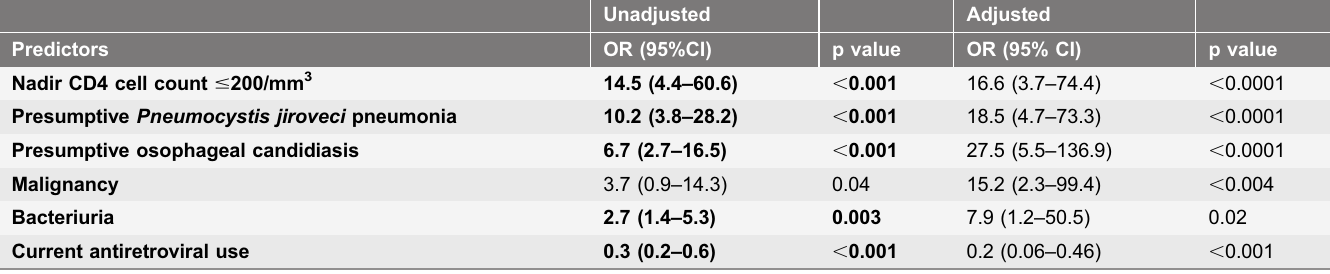
Table 3. Independent predictors of death in hospitalized HIV-infected